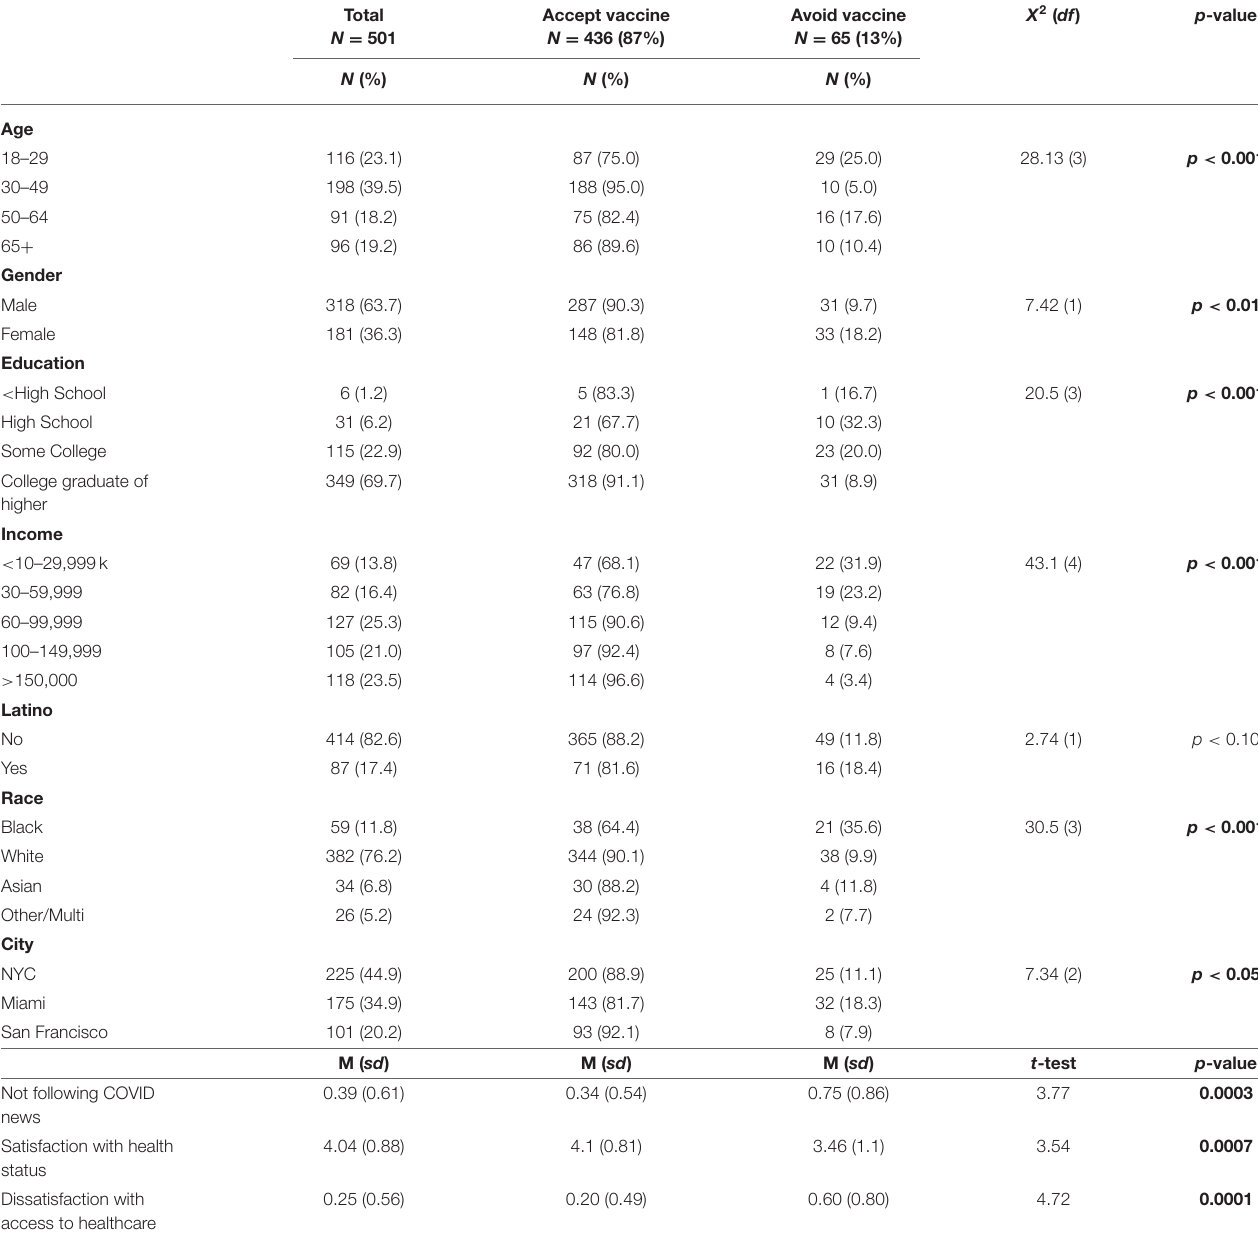
TABLE 1 | Characteristics of sample by willingness to have SARS-CoV-2